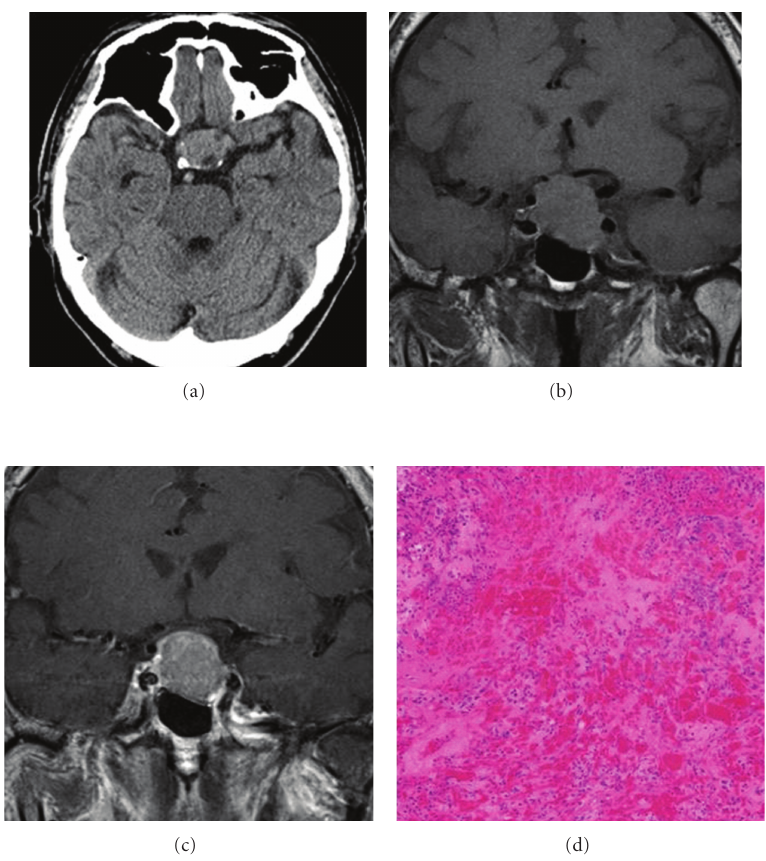
Figure 2: Case 2. CT scan performed 1 hour after onset demonstrates no evidence of intratumoral hemorrhage or acute enlargement of the tumor size (a), T1-weighted MRI performed after onset shows a pituitary tumor extending into the suprasellar cistern. There was no evidence of intratumoral hemorrhage or acute infarction (b), after onset gadolinium-enhanced T1-weighted MRI showing uniform enhancement of the pituitary tumor (c), and pathological examination revealed papillary-patterned adenoma with di ff use hemorrhage and necrosis